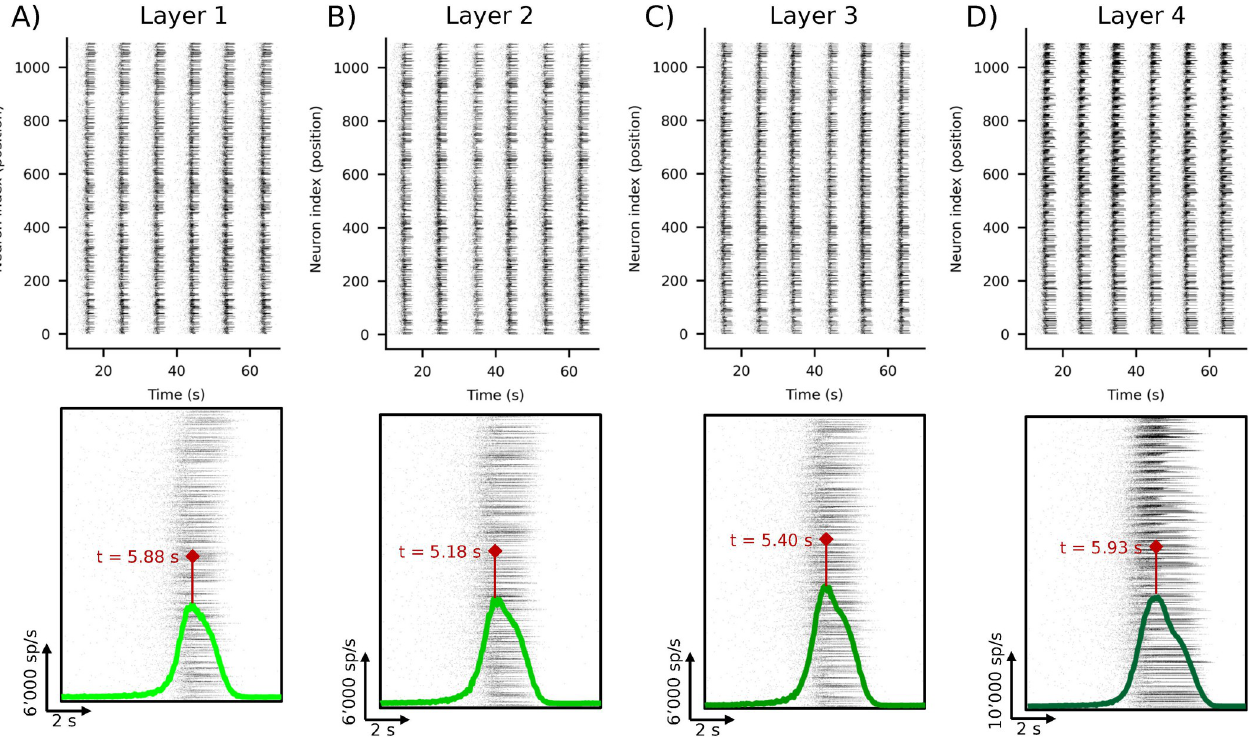
Fig 2. Raster plots and relative IFR traces of the layers of a single population with Gaussian connectivity ( G 3 D ) that guarantees in vitro-like patterns of electrophysiological activity where bursting and spiking activity coexist. ( First row ) 60-s simulated spontaneous electrophysiological activity of the layers of a representative 4-layer 3D network (each panel A-D refers to a single layer of the population, with A being the bottom/readout layer). This configuration allows to reproduce values of firing and bursting rates comparable with the experimental recordings of mature cortical cultures as well as the presence of population events (network bursts) involving most of the neurons of the network. ( Second row ) Close-up of a single population event with super-imposed IFR traces ( green ) and temporal stamps of the relative maxima ( red ).